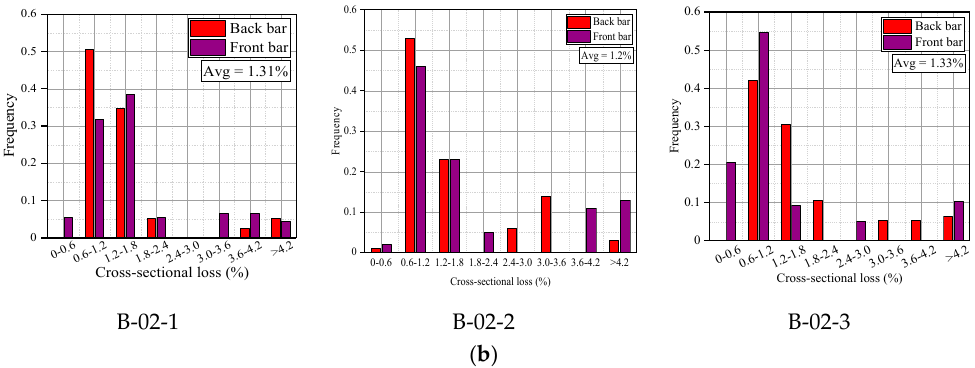
Figure 14. Frequency histogram of cross-sectional loss for corroded steel bars. ( a ) 182 days (Avg means the average value of cross-sectional loss for corroded steel bars); ( b ) 364 days (Avg means the average value of cross-sectional loss for corroded steel bars).